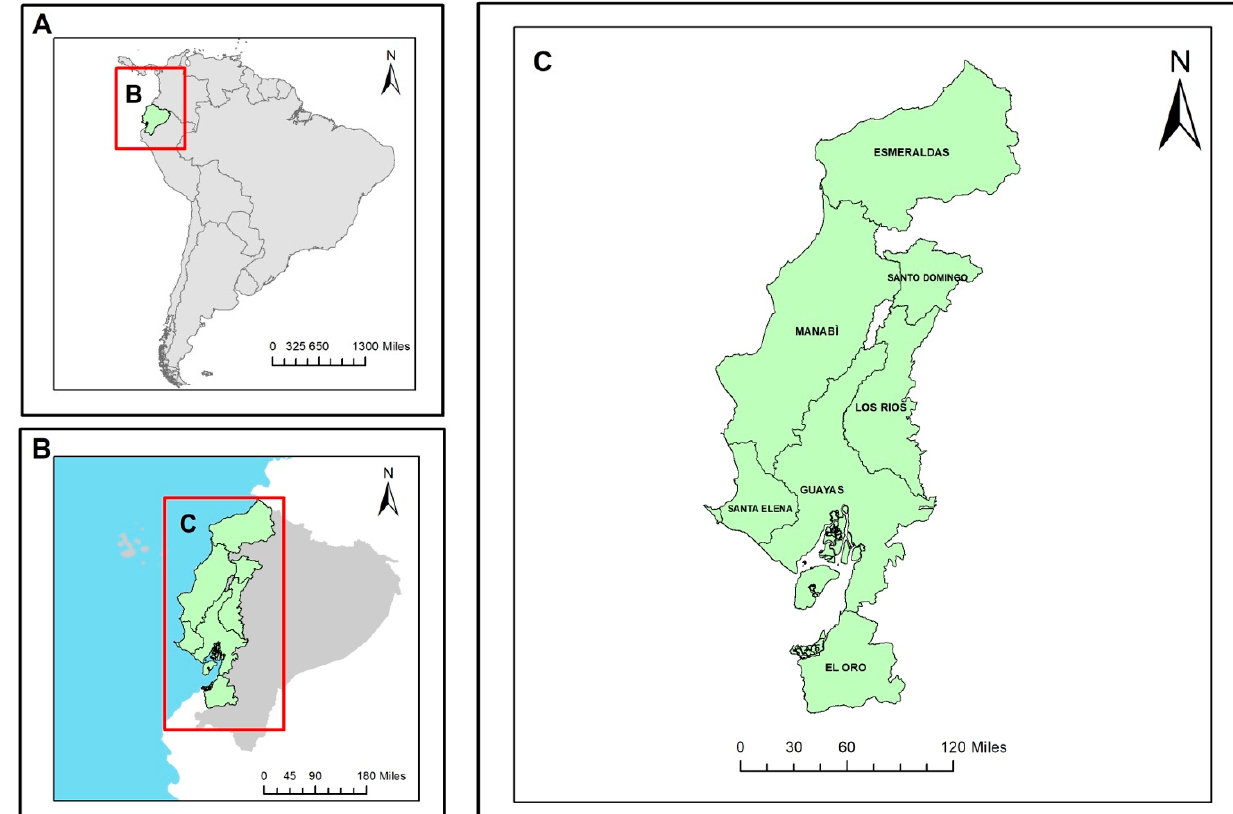
Figure 1. Study area. ( A ) Geographic location of Ecuador; ( B ) Litoral region of Ecuador; ( C ) provinces belonging to the Litoral region.